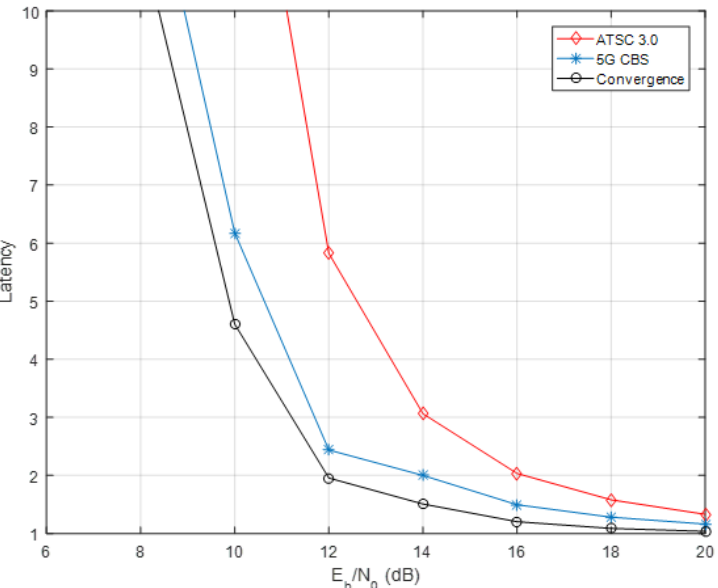
Figure 10. The comparison of the latency performance for the proposed, the 5G, and the ATSC 3.0 emergency alert broadcasts.